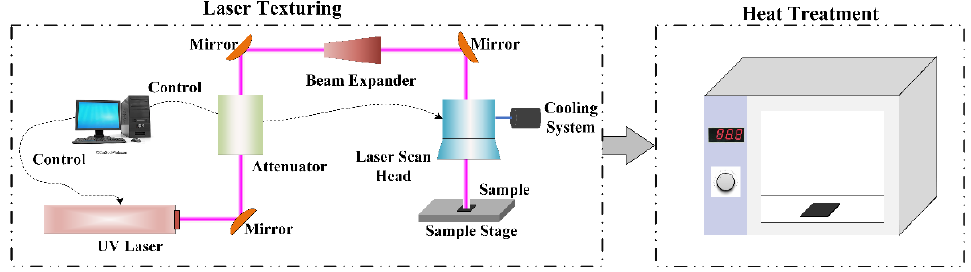
Figure 2. Schematic of the laser-based surface structuring experiments of BMG.